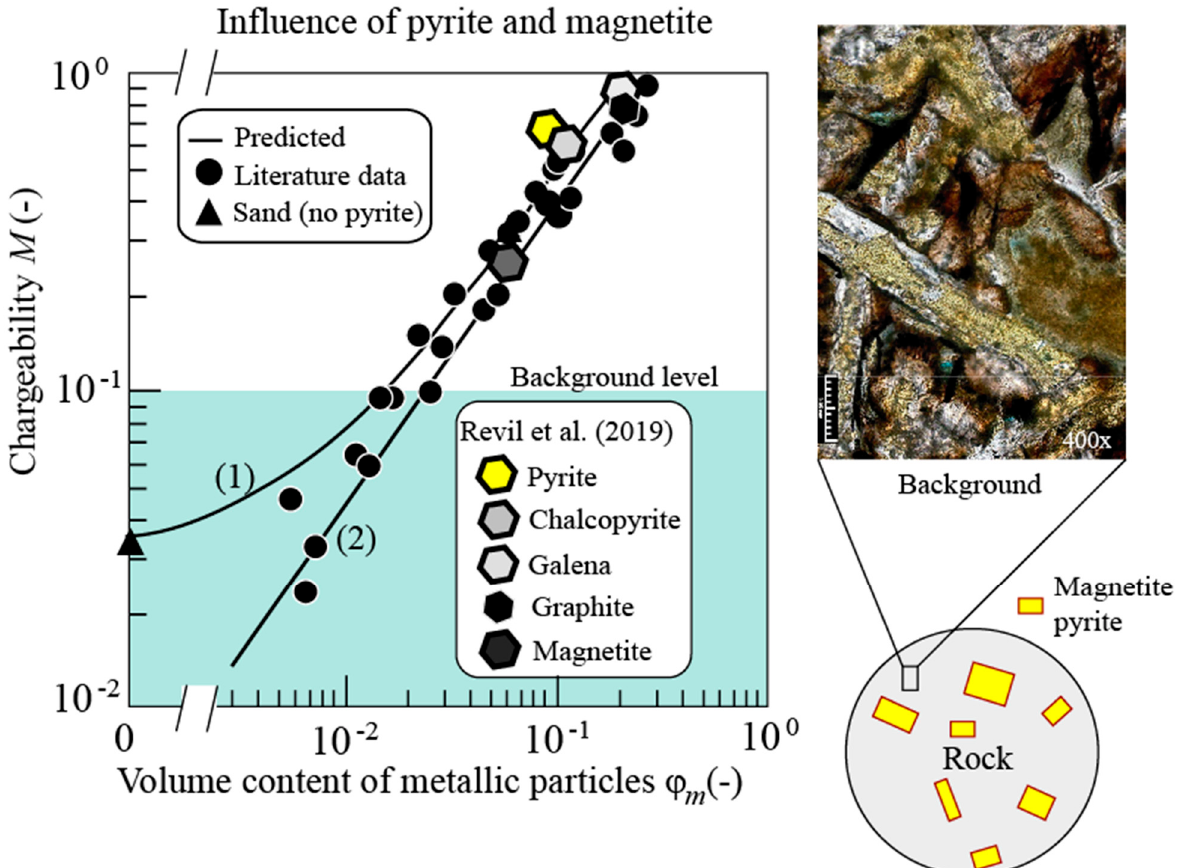
Figure 18. Effect of the presence of semiconductors (pyrite and magnetite) on the chargeability of volcanic materials. For alterated rocks without semiconductors, the chargeability of the background reaches a maximum level, which is given by M b = R = λ /B = 0.10 ± 0.02 [95]. Literature data (pyrite and chalcopyrite) are from Pelton et al. (1978) [11], Mahan et al. (1986) [65], Phillips (2010) [82], and Gurin et al. (2015) [96]. The predicted Trends 1 and 2 are based on Equation (38) and use two distinct values for the chargeability for the background material ( M b ). When the volume fraction of the metal is higher than 1%, it can be easily detected by the induced ‐ polarization method.